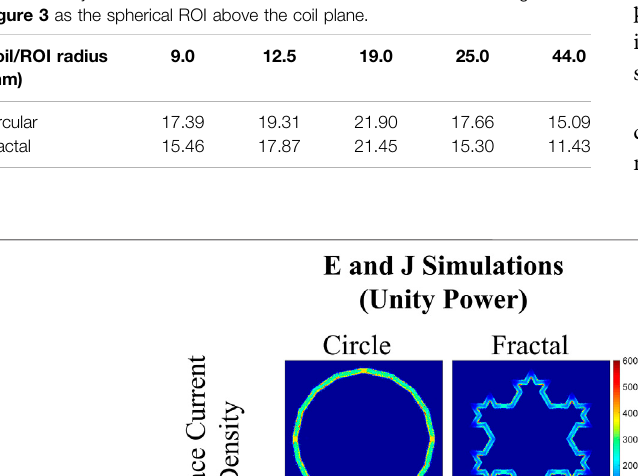
Frontiers in Physics |